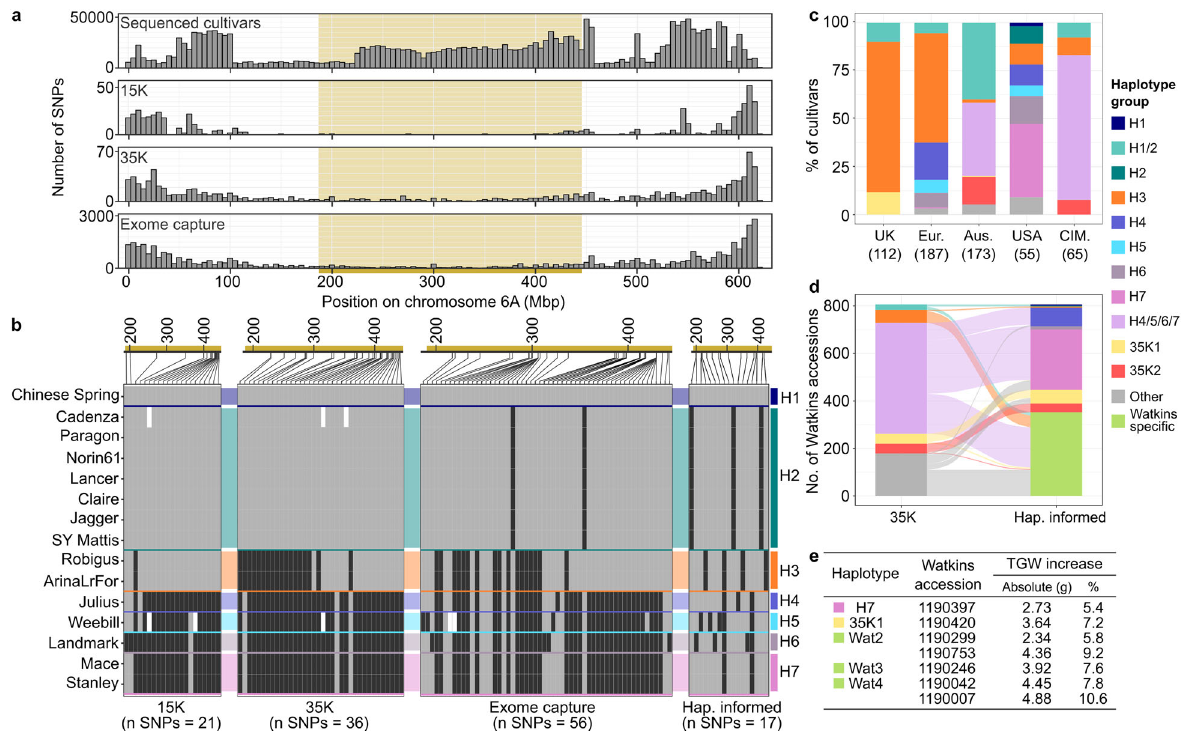
Fig. 4 Identifying and exploiting novel haplotypes from the Watkins landraces. a Physical distribution of SNPs in 5-Mbp bins across chromosome 6A based on the 15 sequenced cultivars and other genotyping platforms (15K iSelect, 35K Axiom, exome capture). Beige shading indicates minimum haplotype block (MHB). b Allele calls extracted from sequenced cultivars for informative SNPs in MHB based on the genotyping platforms shown in ( a ) and allele calls for 6A haplotype-informed (Hap. informed) markers. Physical positions of SNPs are shown above each panel. Grey = reference allele, black = alternative allele. c 6A haplotypes present in germplasm panels based on genotyping platforms in ( b ) (number of cultivars in parentheses). ‘ UK ’ = UK Recommended List (35 K) 24 , ‘ Eur. ’ = European elite winter wheat (15K) 23 , ‘ Aus. ’ = Australian cultivars (35K) 24 , ‘ USA ’ = USA cultivars (exome capture) 11 , ‘ CIM ’ = CIMMYT Core Germplasm (CIMCOG) lines (35K) 24 . d 6A haplotypes in the Watkins landrace panel ( n = 806) based on 35K array (left) 61 and haplotype-informed markers (right). Full details of lines and haplotype allocations in Supplementary Data 10. Fill colour legend corresponds to both ( c ) and ( d ). e Summary of Paragon (H2) x Watkins bi-parental populations with QTL for increased thousand grain weight (TGW) across the MHB. See Supplementary Table 1 for additional